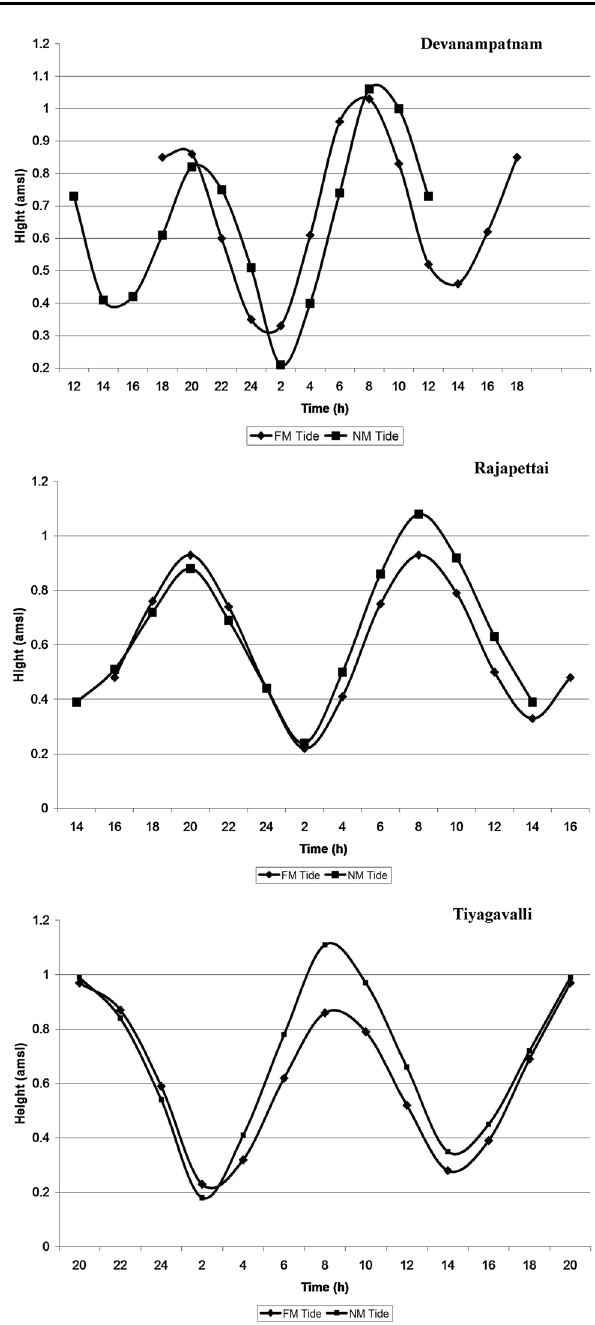
Fig. 3 Tidal Variation during FM and NM at Devanampatnam, Raja- pettai and Tiyagavalli